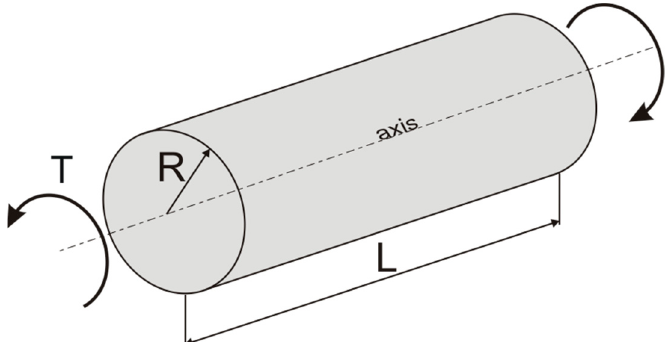
Figure 5. Circular bar subjected to torsion.